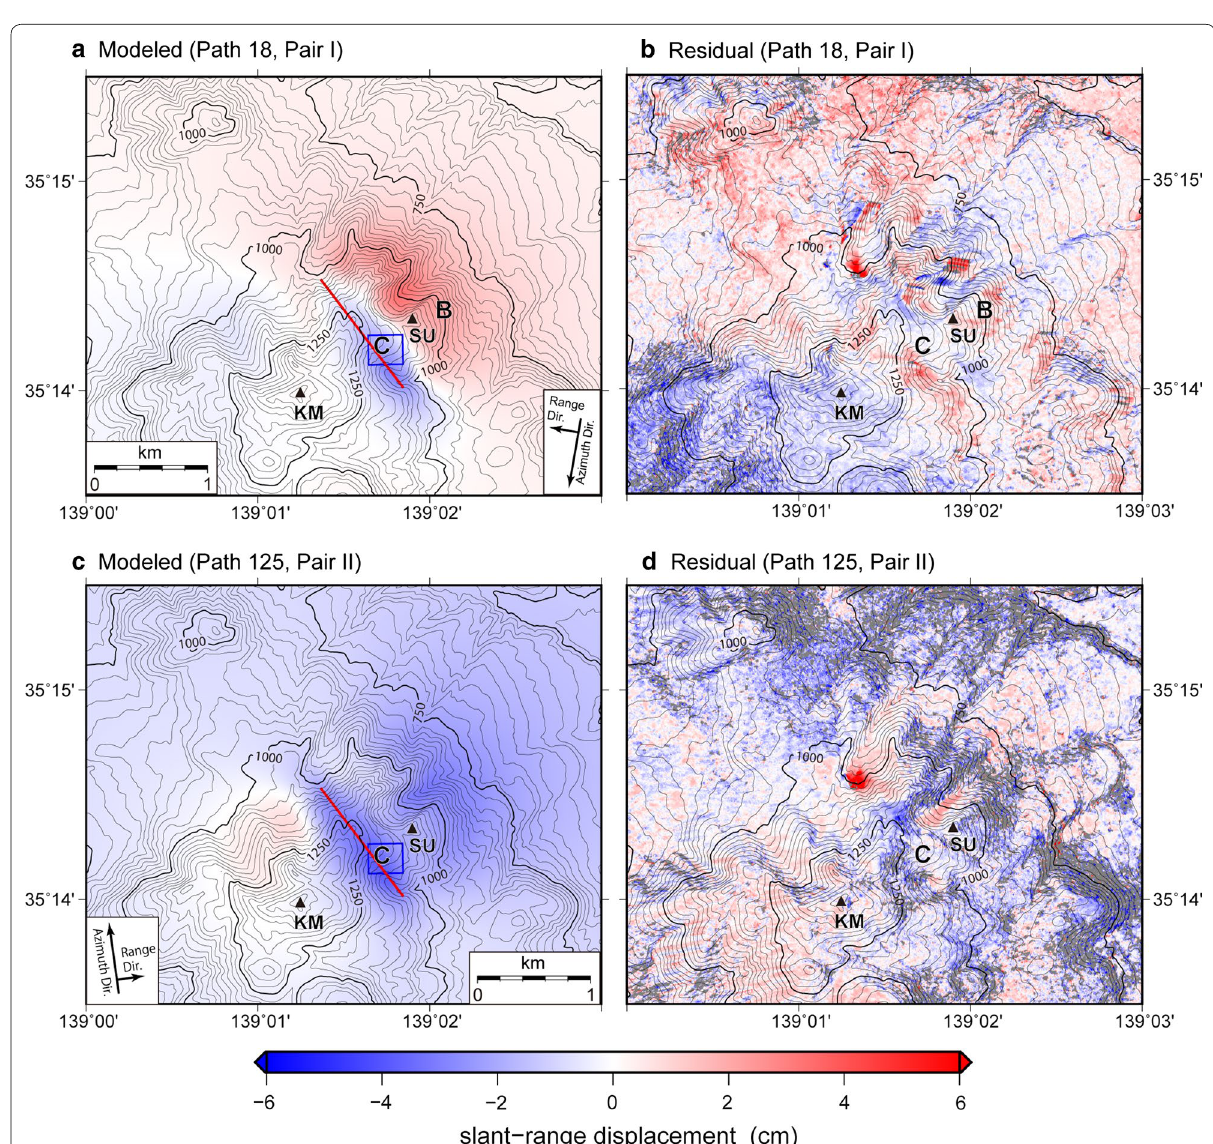
Fig. 7 Result of the inversion estimating the open crack and deflation sill model. a Modeled surface displacements, and b residuals between model and observation for Pair I. c Modeled surface displacements, and d residuals between model and observation for Pair II. B and C indicate displace- ment areas mentioned in the text. KM and SU show the summits of Kamiyama and Sounzan, respectively. Offset parameters were 1.95 mm for Pair I and –9.20 mm for Pair II. The red line and blue rectangle show the estimated open crack and deflation sill, the parameters of which are listed in Table